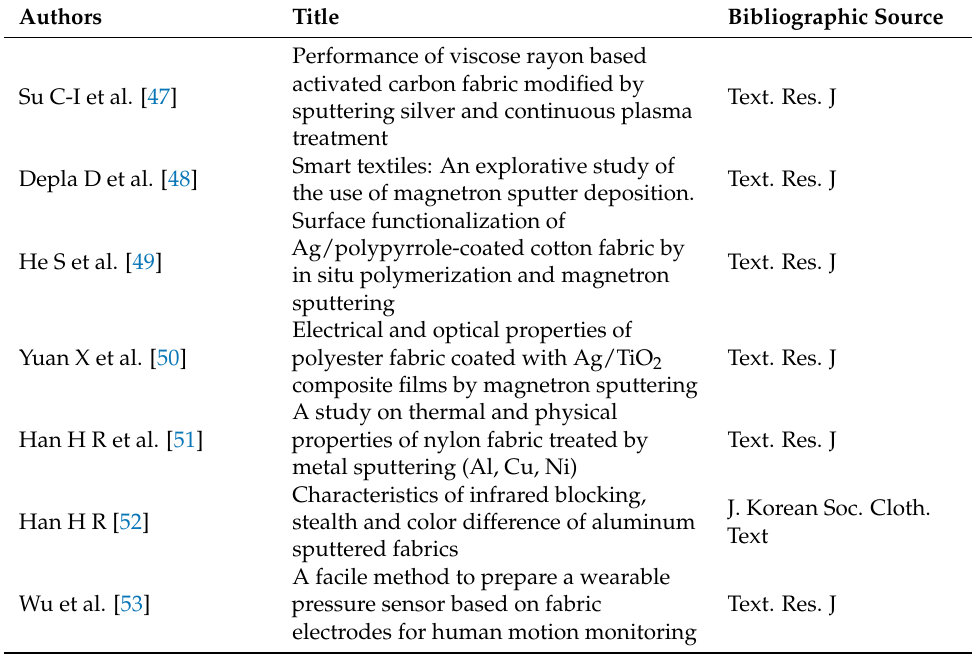
Table 2. Systematization/enumeration of sputtering papers with bibliographic